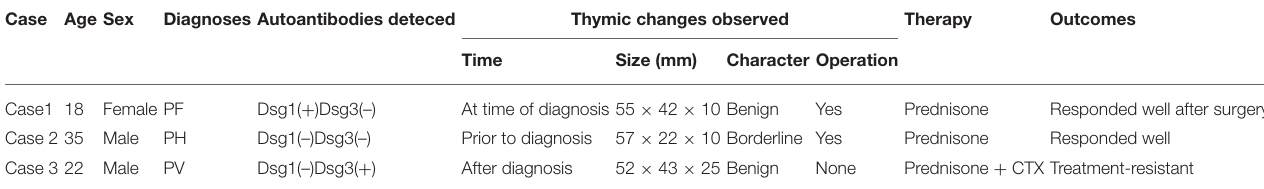
TABLE 1 | Clinical characteristics of included